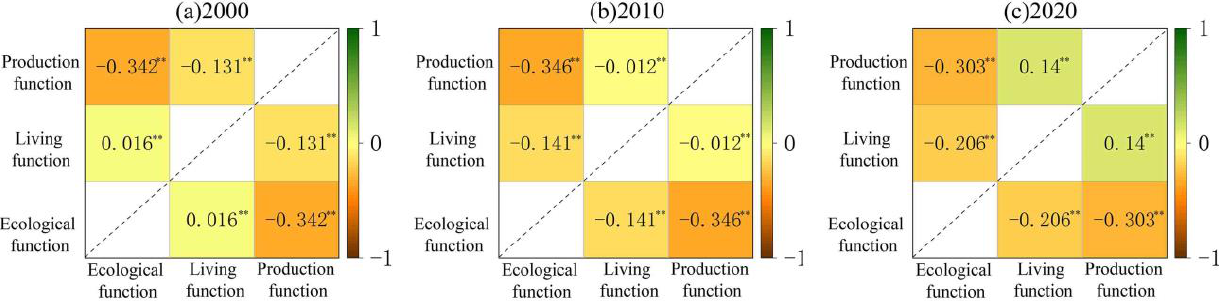
Figure 5. Correlations among primary land functions in the Sino-Vietnamese border region in ( a ) 2000, ( b ) 2010, ( c ) 2020. Symbol “*” means a significance level of 0.05, and “**” represents a signifi- cance level of 0.01.